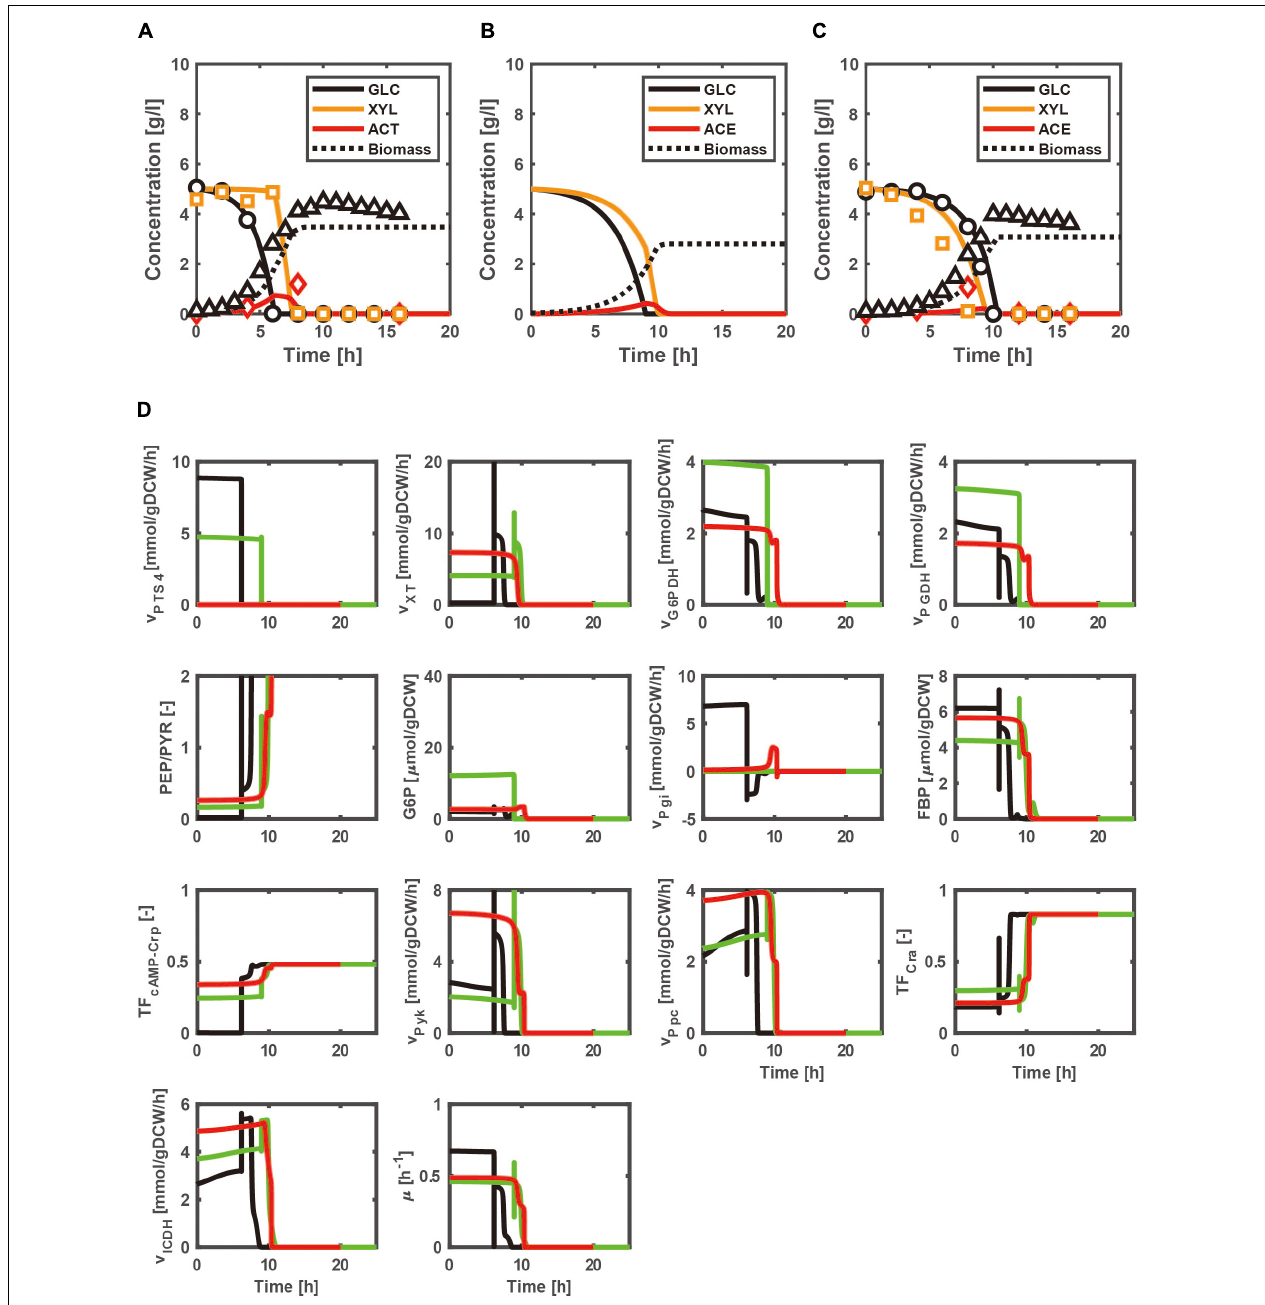
FIGURE 2 | Simulation results of the batch cultivations of the wild type, and pgi - and ptsG - knockout mutants grown on a mixture of glucose and xylose under aerobic condition. The lines and symbols represent the simulated and experimental (Matsuo, 2011) data for the time courses of extracellular metabolites and biomass concentrations of wild type (A) , and pgi - (B) and ptsG - (C) knockout mutants, respectively. The black, green, and red lines represent the simulated time courses of the intracellular metabolic changes for the cases of the wild type, pgi mutant, and ptsG mutant, respectively (D)